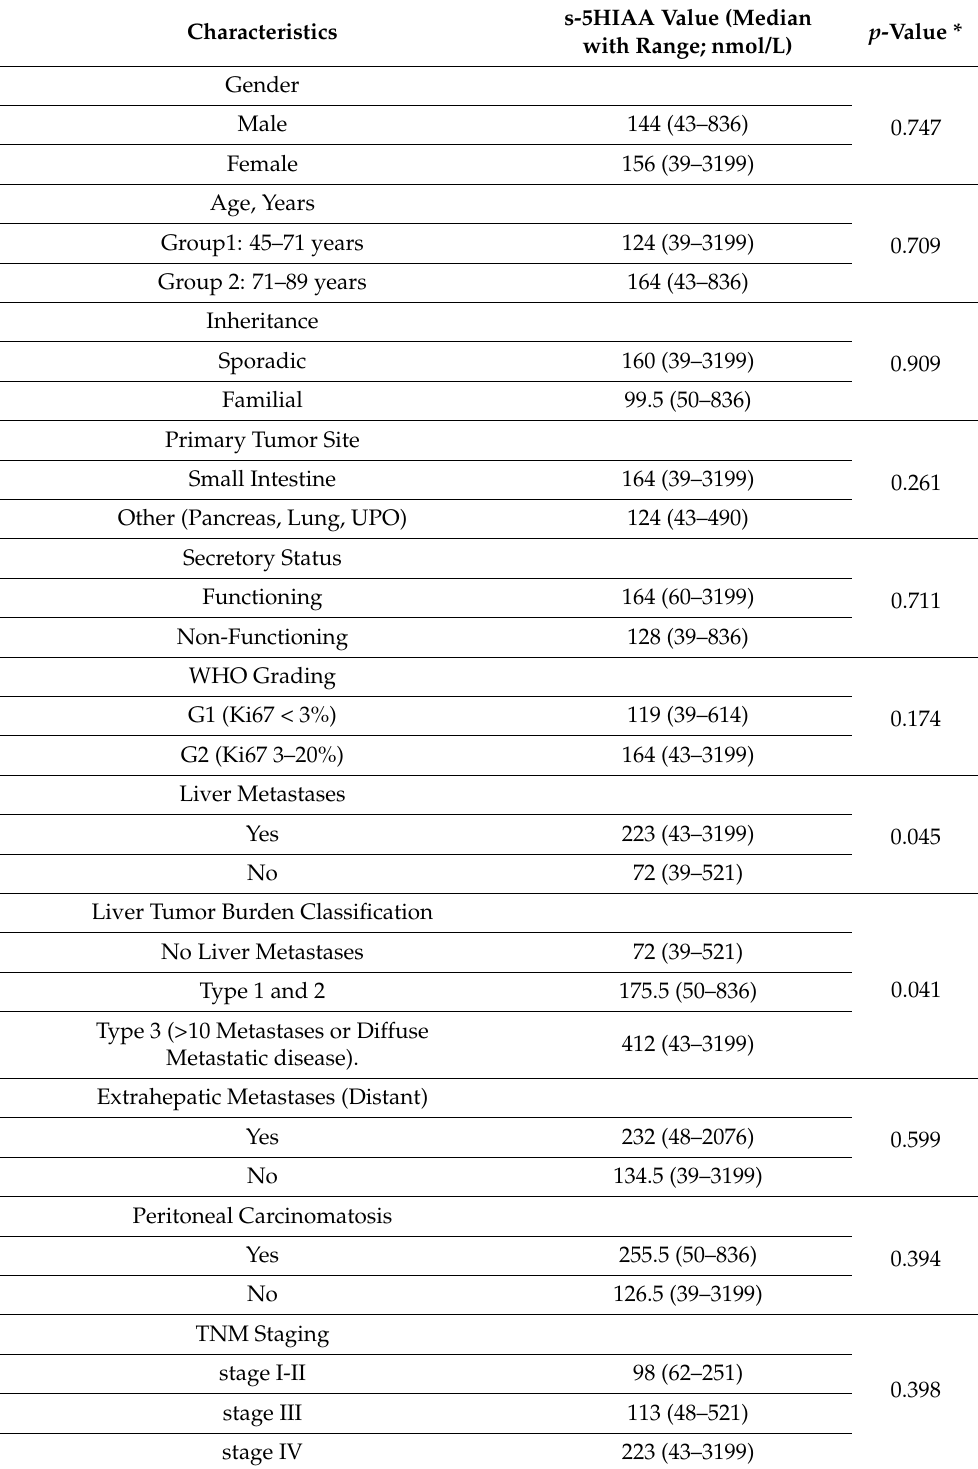
Table 2. Patient- and tumor-related parameters in relation to serum 5HIAA values at baseline